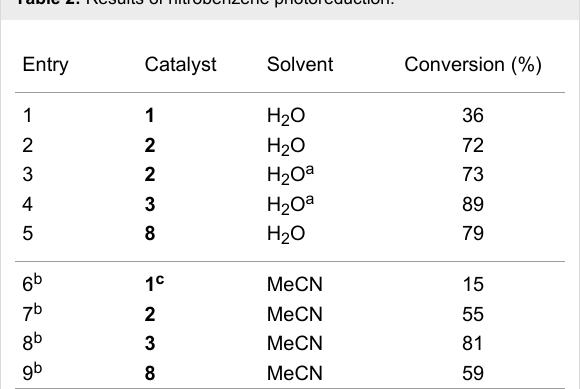
Table 2: Results of nitrobenzene